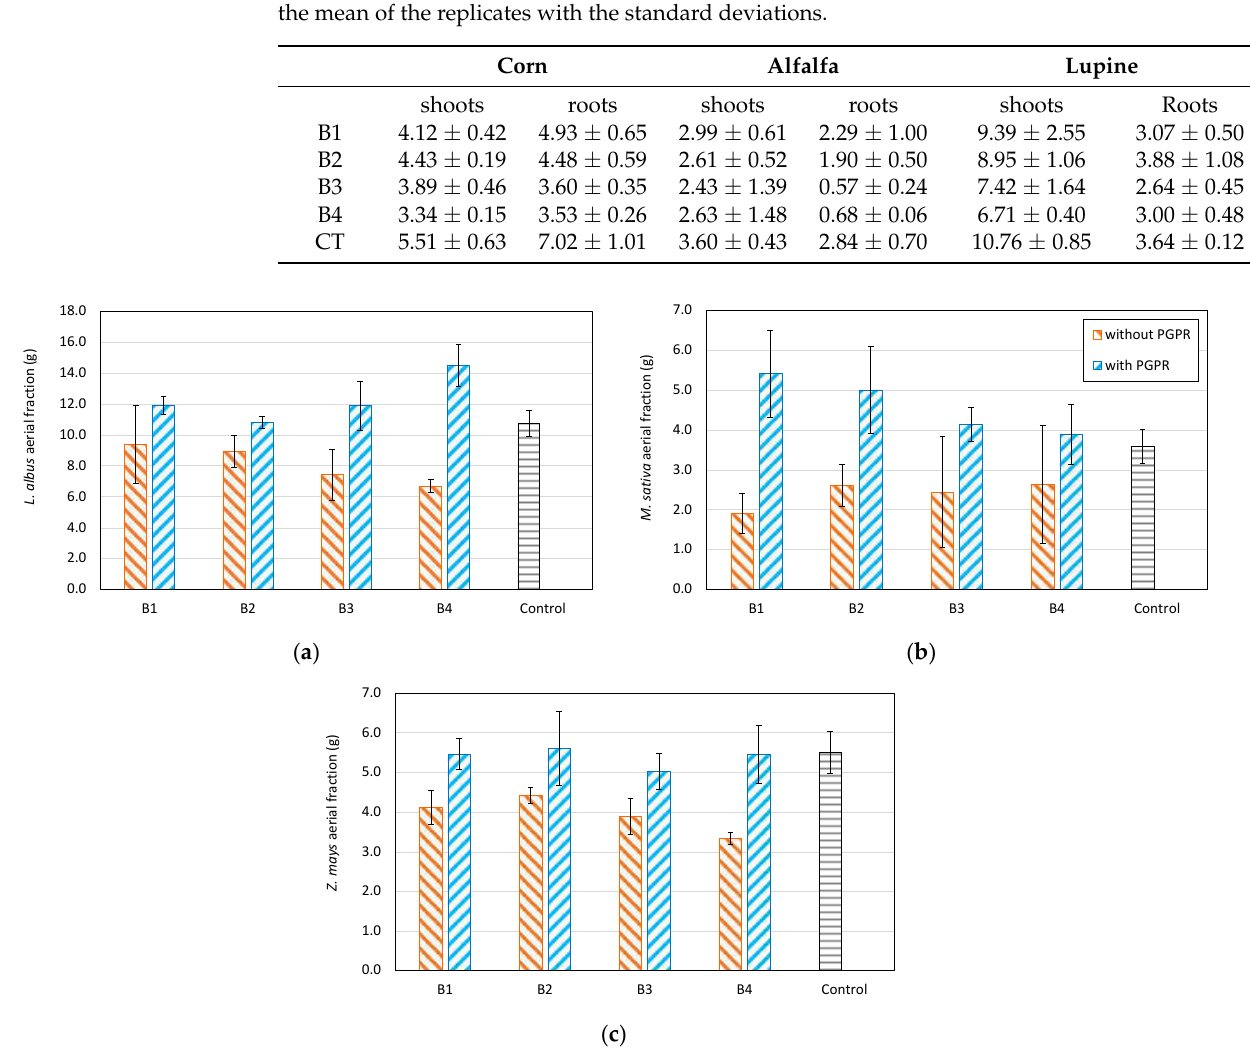
Figure 6. Comparative growth of the aerial part of Lupine ( a ), Alfalfa ( b ) and Corn ( c ) on the contaminated soils without (orange bars) and with (light blue bars) the inoculation of the two isolated and characterized PGPB strains with respect to control soil not contaminated (grey